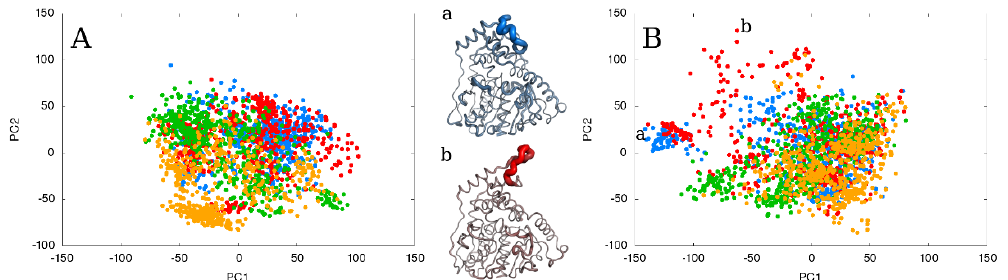
Figure 4. The results of normal modes analysis of five repetitions using particular FL models as a starting point for simulation during ( A ) 100 and ( B ) 500 ns MD runs. For picture clarity, only every 5th point on the right panel is shown. The points representing FL_m1 are blue, FL_m2 are red, FL_m3 are green, and FL_mDOPE are orange. The points representing each group of simulations with a particular FL model used as a starting point are widely spread and overlap. On the left panel, the points representing the FL_mDOPE model populate a region of the conformational space which is not visited by other models. On the right panel, the points representing the FL_m1 and FL_m2 models populate a region of the conformational space not visited by other models (shown as ( a ) (blue) and ( b ) (red)) which is related to movements of the N-terminal meander. The thickness of each structural element is related to its movements against the averaged structure.